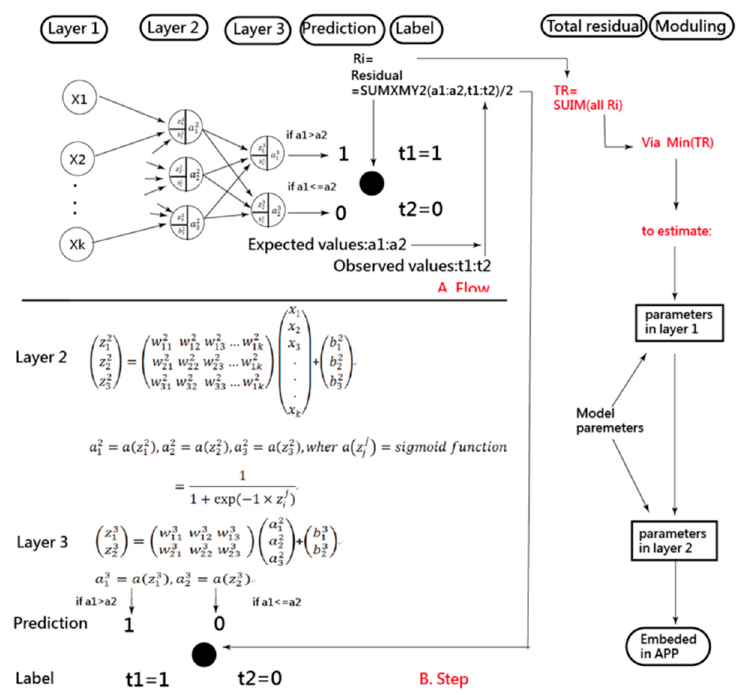
Figure 1. The process of estimating parameters in the artificial neural network (ANN) model.